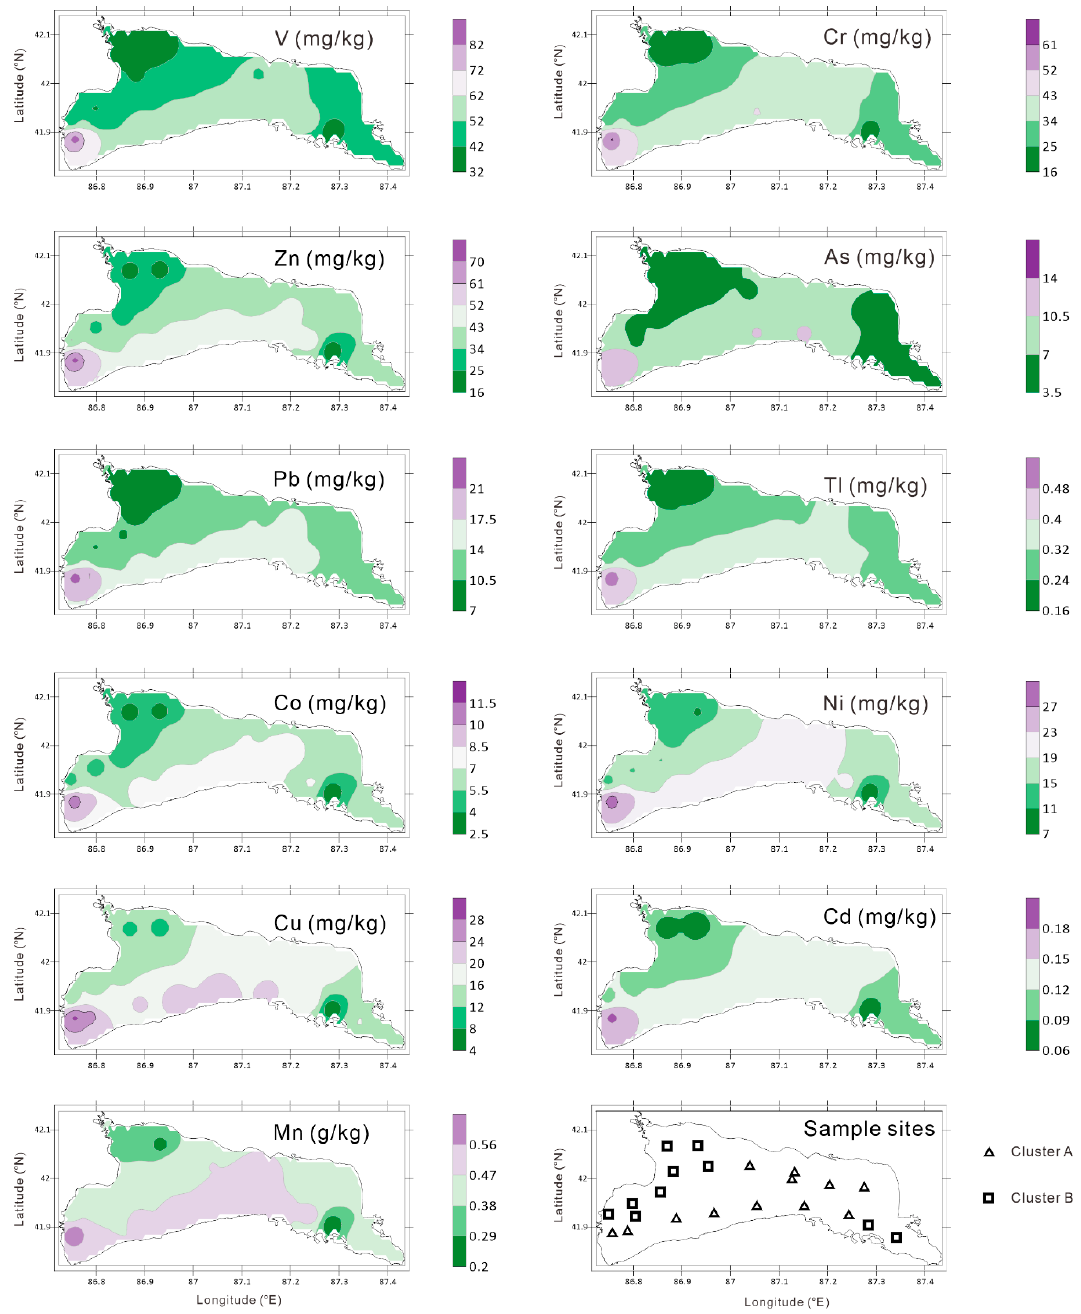
Figure 6. The spatial distribution of the PTEs and two-way cluster results of the sampling sites (lower left part) for the surface sediments of Lake Bosten.